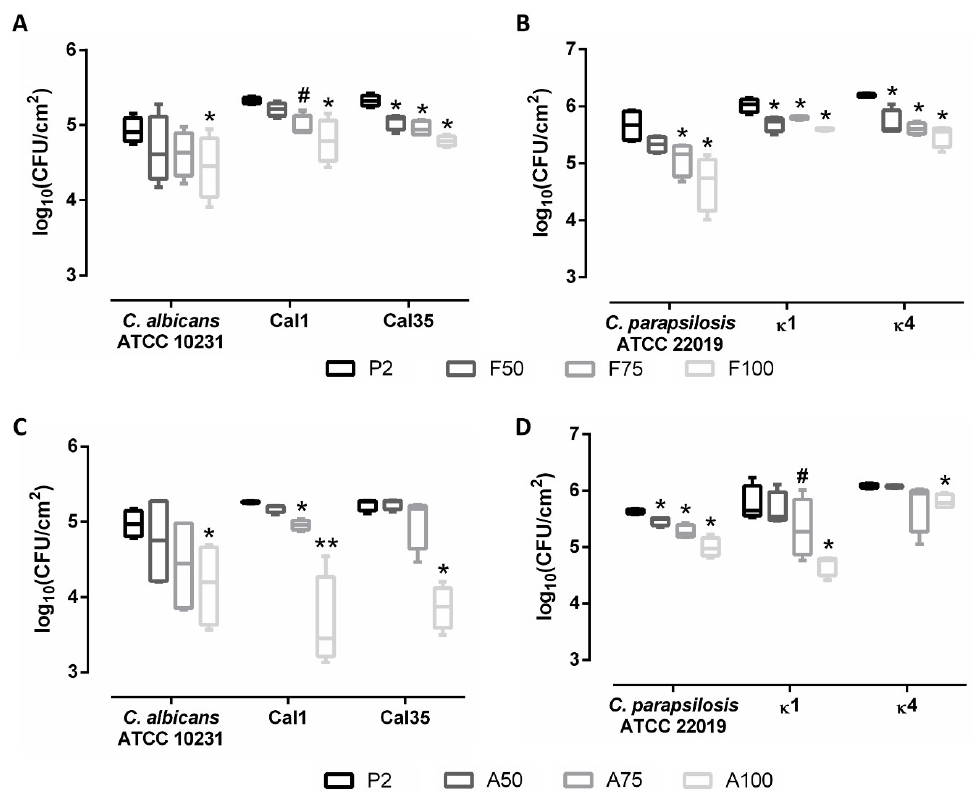
Figure 5. Quantification of biofilms formed on titanium pieces coated with P2 (control), fluconazole-loaded coatings ( A , B ), or anidulafungin-loaded coatings ( C , D ). Data are represented as median and interquartile range of the log 10 (CFU/cm 2 ) estimated by drop plate in at least three independent experiments. *: 0.05 > p > 0.01; **: p < 0.01; #: 0.051 > p > 0.099 for Wilcoxon test between the control coating (P2) and the other coatings.